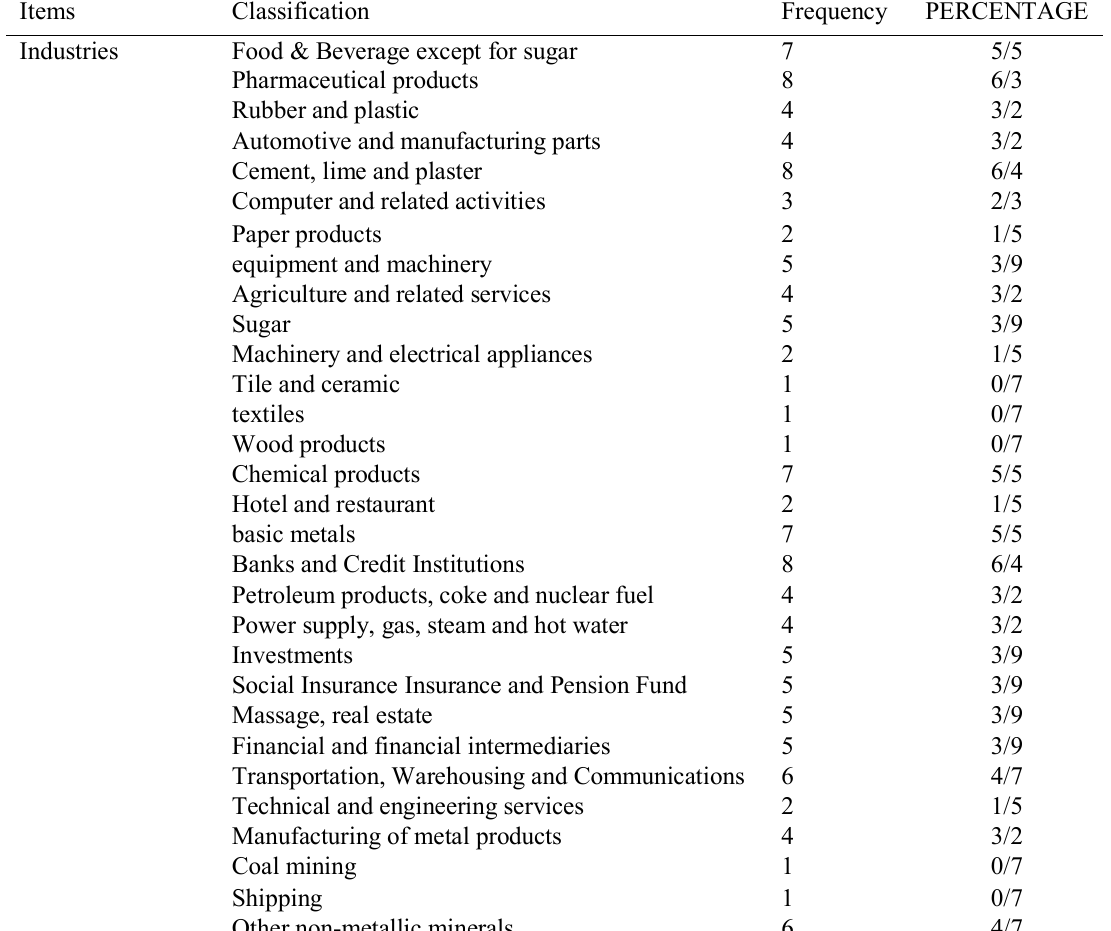
Table 3. Characteristics of respondent